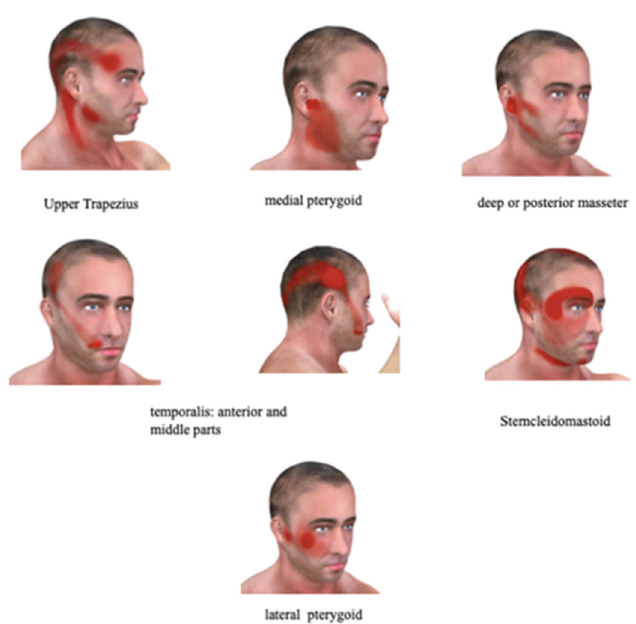
Figure 1. The referred pain patterns of relevant neck and head muscles that refer pain to the face in the trigeminal nerve distribution. The names of the muscles whose referred pain pattens are shown are noted under each individual illustration. Note that the sternocleidomastoid muscle can refer to the side of face primarily in the distribution of the second division of the trigeminal nerve in addition to its more common referral over the eye in the distribution of the first division. Many of these muscles are associated with the function of the temporomandibular joint and may be activated in disorders of the joint as well as in situations of bruxism and of clenching. (Images from C Triggerpoints 3D, used with permission).